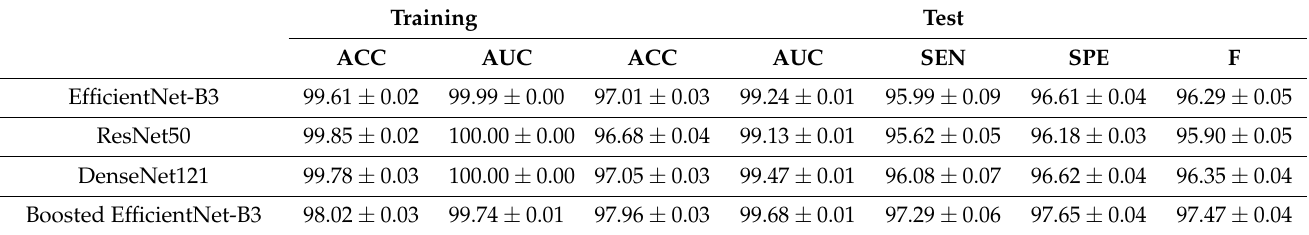
Figure 1. The classification results (%) of different methods on the test set of the Rectified Patch Camelyon (RPCam) dataset. Boosted EfficientNet-B3 outperforms the other three models in all evaluation metrics. Error bars represent standard deviation errors. ACC, Accuracy; AUC, Area Under the Curve; SEN, Sensitivity; SPE, Specificity; F, F1-Measure. Table 1. Classification results (%) of different methods for the RPCam dataset.